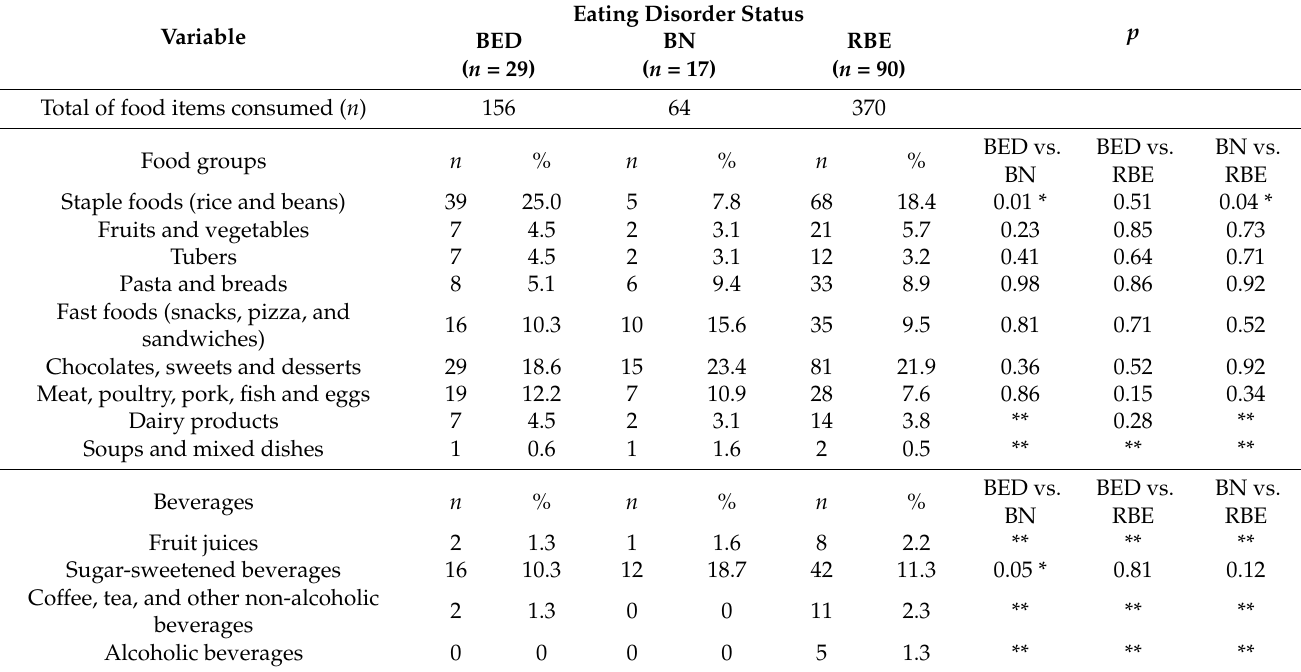
Table 3. Frequency of food groups consumed during objective binge eating episodes according to eating disorder